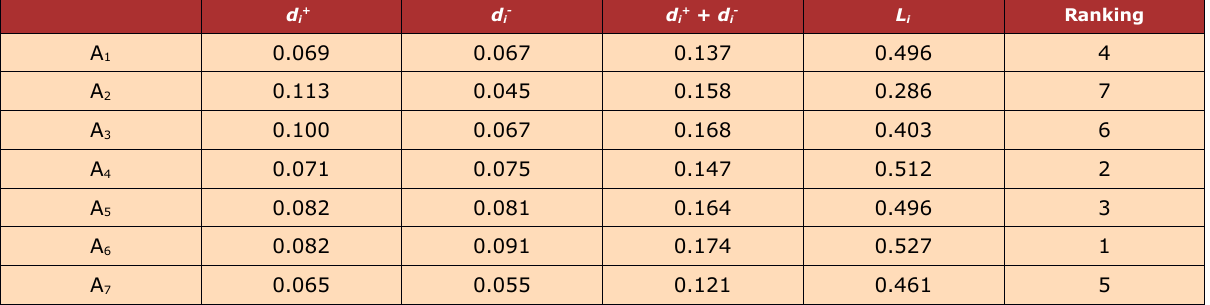
Table 15. Final performance indices of sustainable